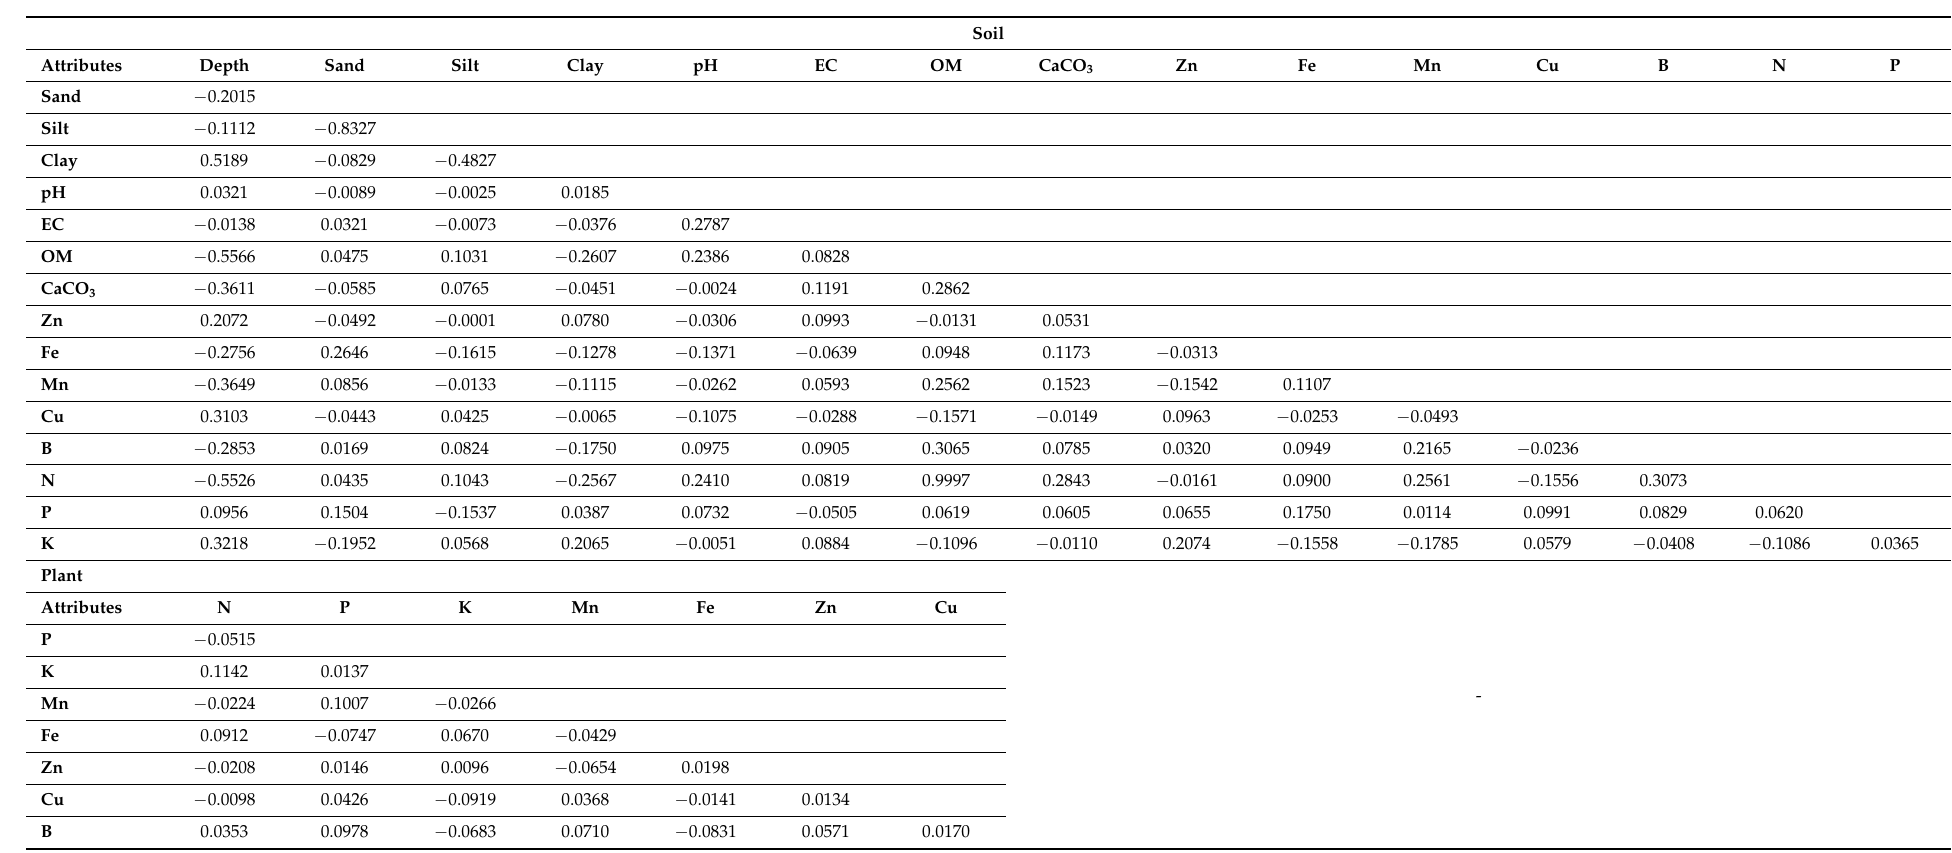
Table 6. Pearson correlation of studied soil and plant